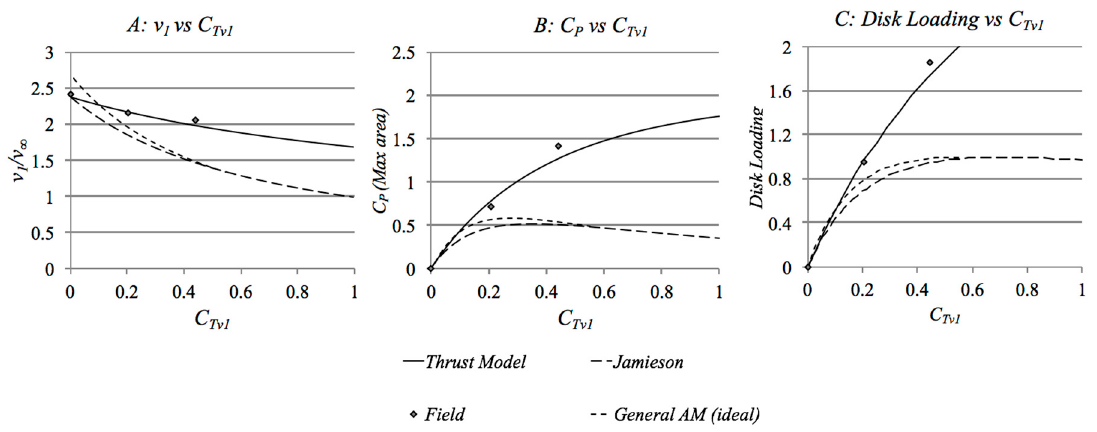
Figure A7. General AM, Thrust Model, and Jamieson’s model compared to Field Test Results for ( A ) v 1 vs. C Tv 1 ( B ) C P vs. C Tv 1 ( C ) Disk Loading vs. C Tv 1.